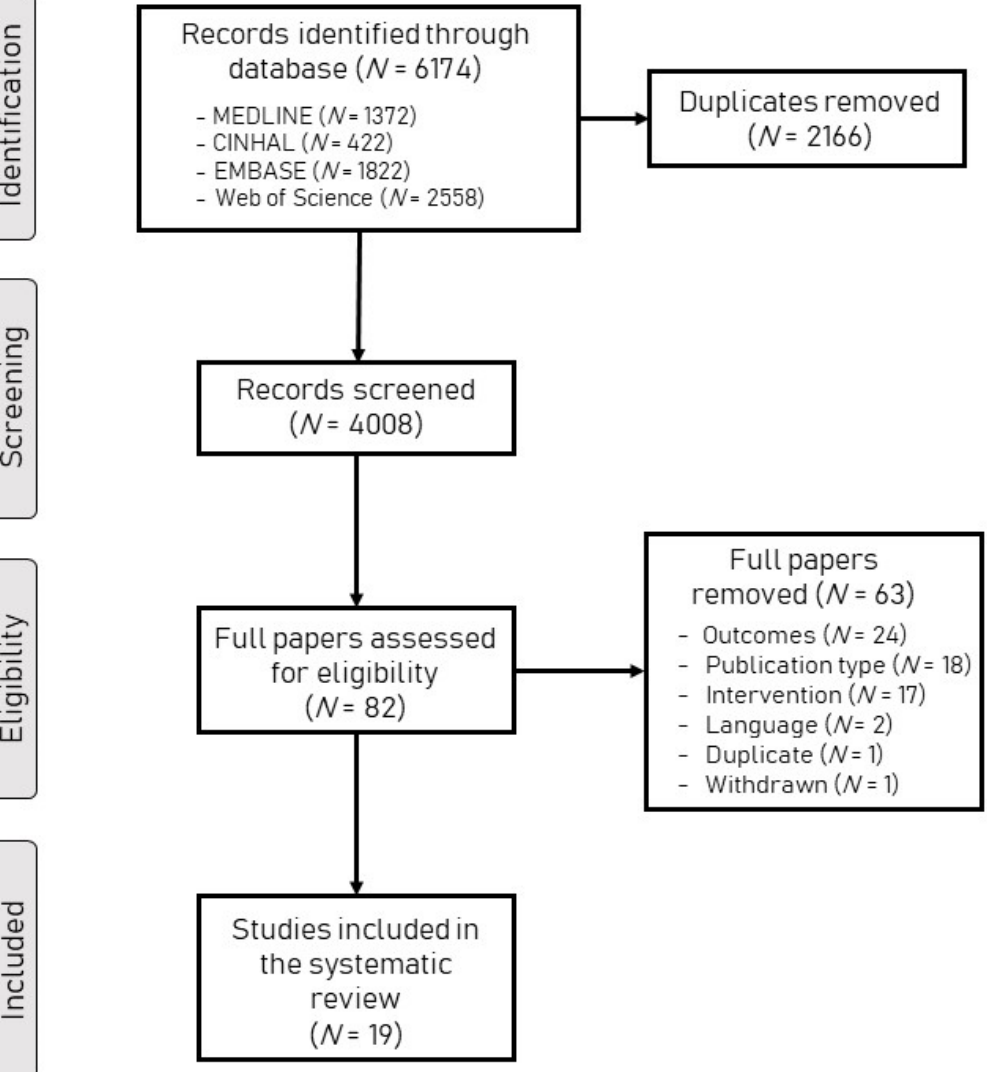
Figure 1. The flowchart presenting the protocol of this systematic review.